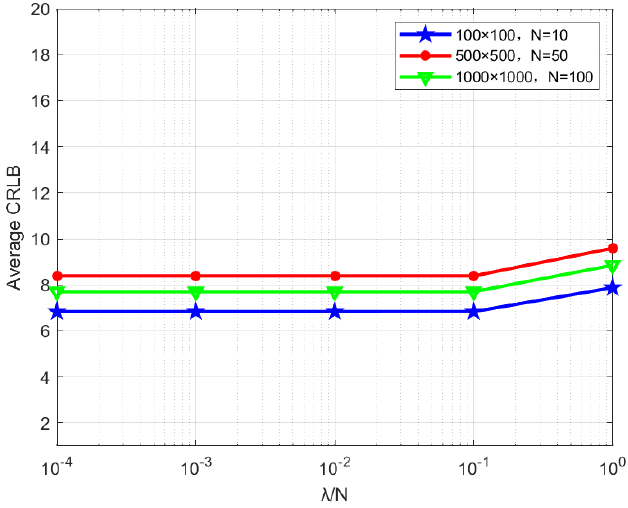
Figure 6. Effect of penalty factor on average CRLB.